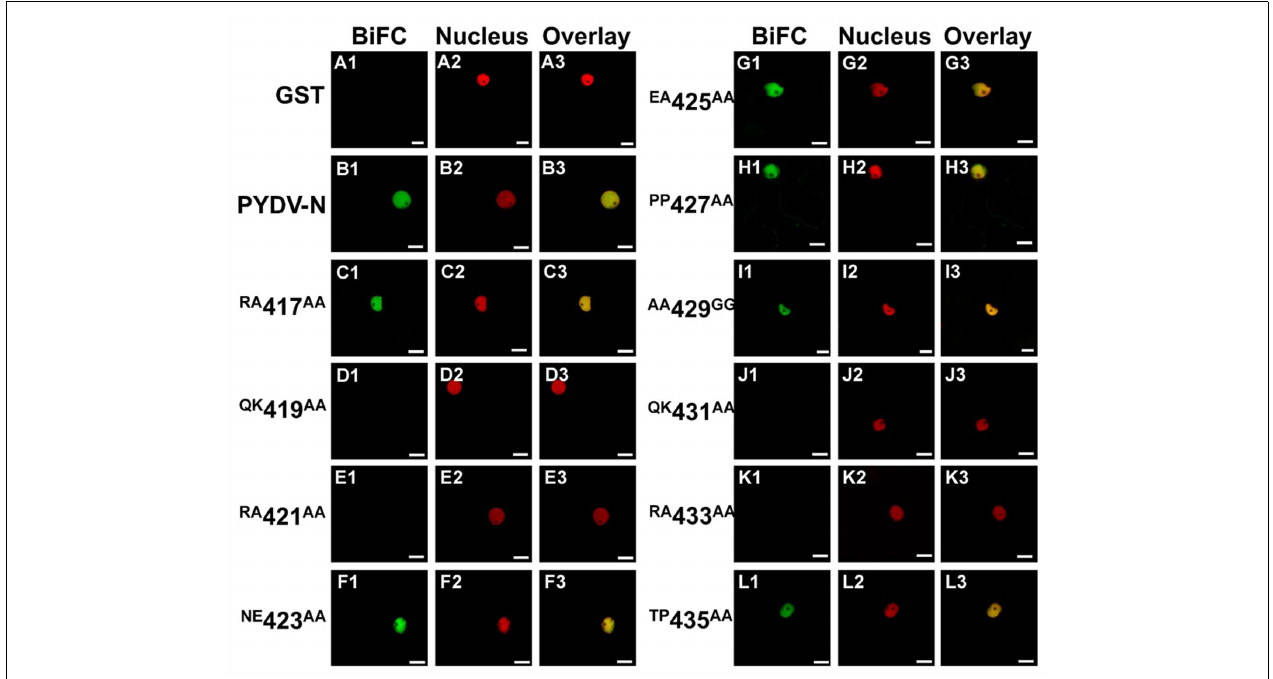
2, and 3 show micrographs ofYFP (BiFC), nuclear marker (Nucleus), and the resultant overlay, respectively. (A1–A3) Non-binding control GST. (B1–B3) BiFC between Importin- α and PYDV-N. (C–L) BiFC between Importin- α and double mutants of PYDV-N, described in Figure 1 . Scale bar = 10 μ m.